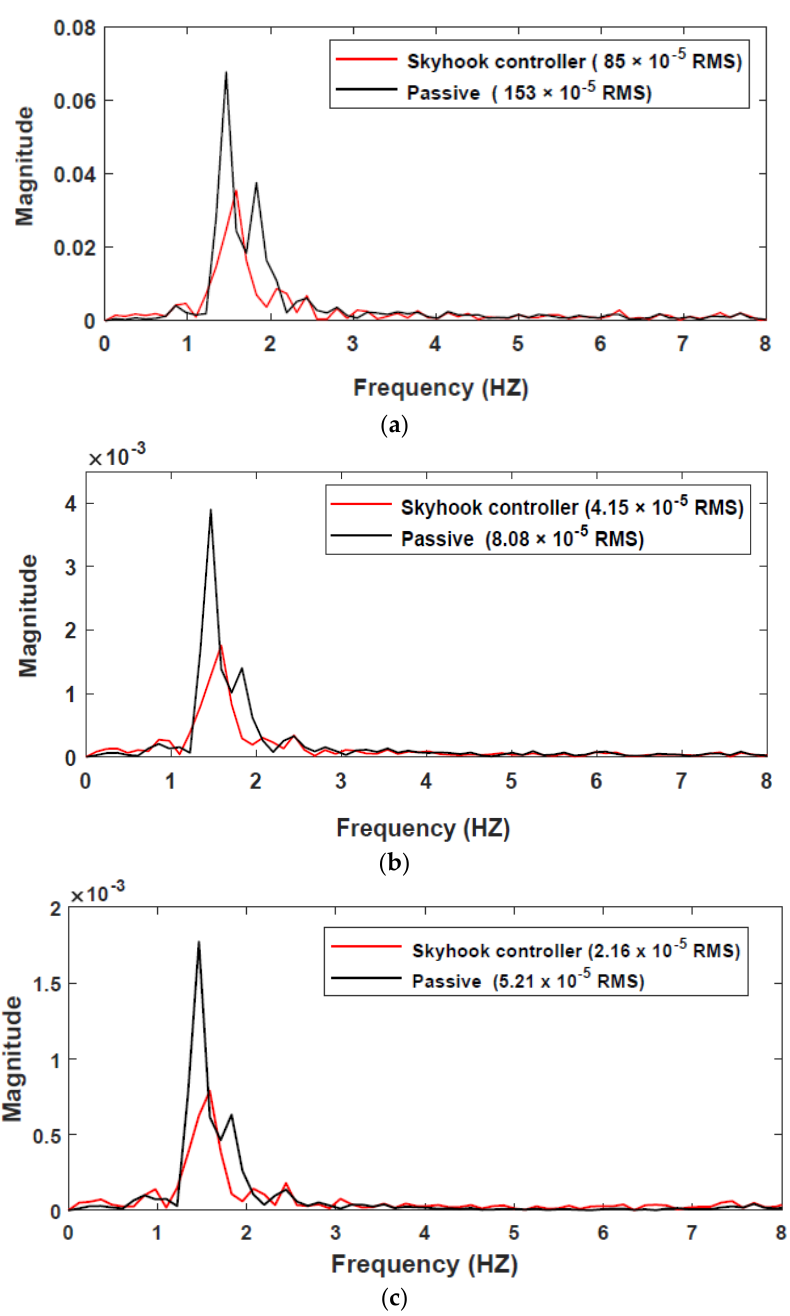
Figure 15. Frequency responses for IWM under random road excitation: ( a ) vertical acceleration from the center of gravity; ( b ) suspension deflection; ( c ) tire deflection.